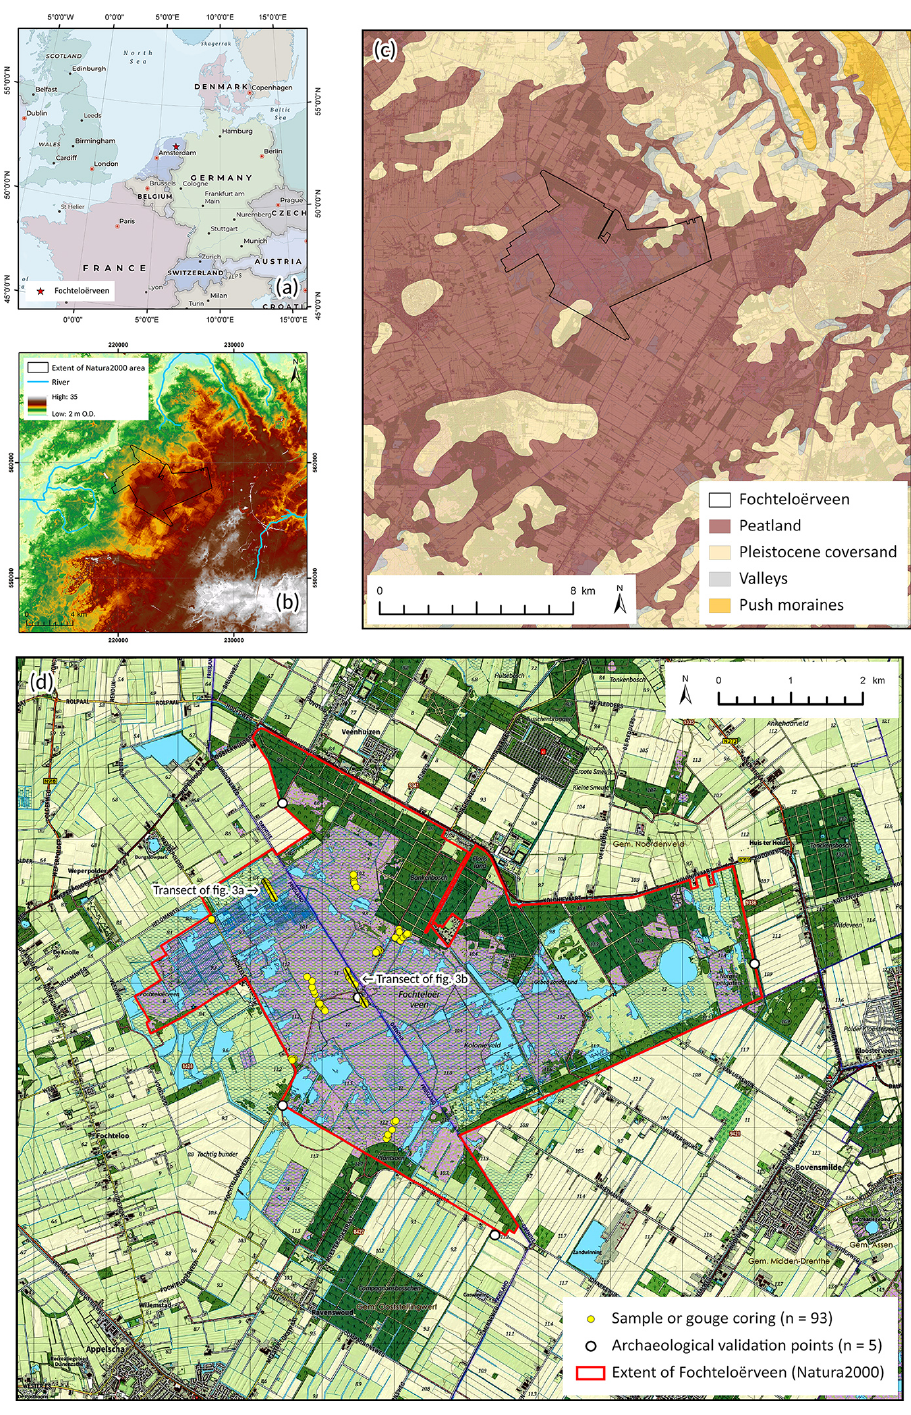
Figure 2. (a) Location of the Fochteloërveen peat remnant within Europe (ESRI, 2022); (b) digital elevation model (DEM) of the wider area around Fochteloërveen (version AHN3, horizontal resolution 5m, vertical resolution 0.1m; AHN, 2021a, b), indicating the main drainage pattern (Ministerie van Verkeer en Waterstaat, 2007). Coordinates are in metres (Dutch RD-new ( Rijksdriehoeksstelsel ) projection). Extent of the Fochteloërveen Natura 2000 area is indicated (Ministerie van Economische Zaken, 2018); (c) palaeogeographical map of Fochteloërveen and surroundings, showing reconstructed situation for 500BCE (2450calBP) as indicated by the Dutch national palaeogeographical map series (Vos et al., 2020; RCE, 2022); (d) topographical map of Fochteloërveen (OpenTopo; Van Aalst, 2022), showing coring locations (see Sect. 3.1.1 and 3.1.2) and position of archaeological validation points (for details see Table 2). Peatland is indicated with purple colours. The area surrounding Fochteloërveen shows the landscape structure that resulted from historical peat colonies, peat-cutting activities and agricultural